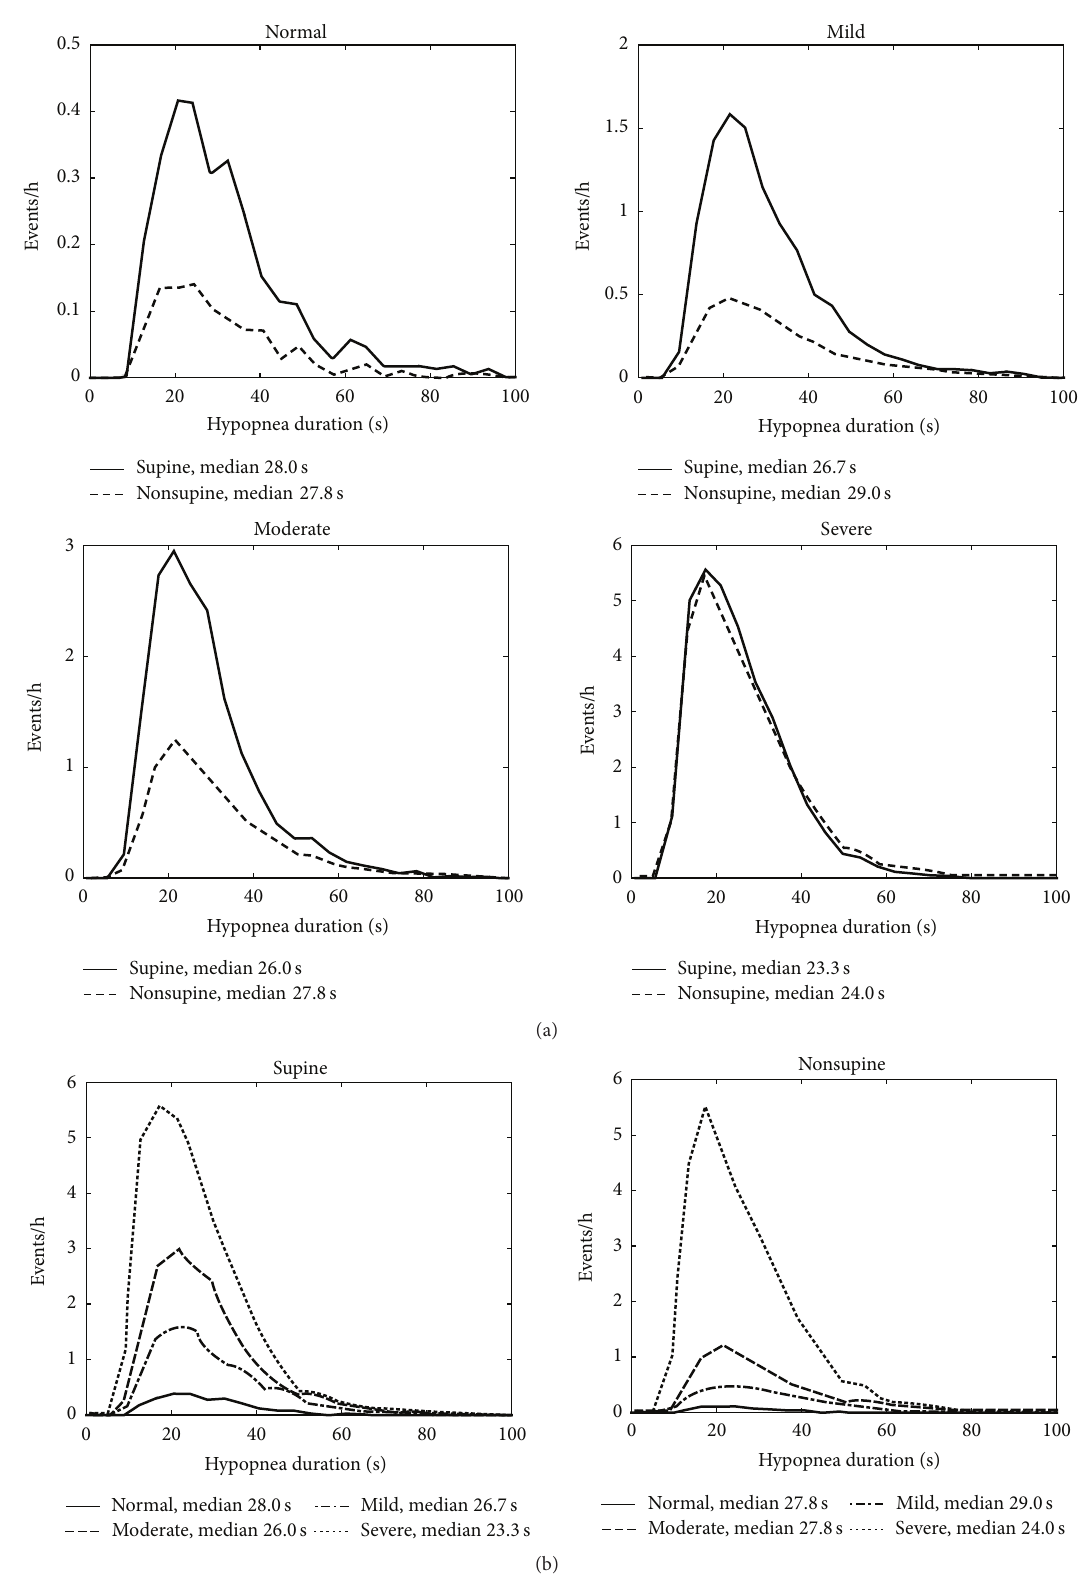
Figure 4: (a) Positional sleeping time adjusted distributions of the durations of individual hypopnea events in supine and nonsupine positions in different OSA severity categories and (b) distributions in nonsupine and supine positions as a function of OSA severity. In every OSA severity category, excluding normal category, the hypopnea events were slightly longer in nonsupine position than in supine position. Based on the mixed model analysis, the differences are statistically significant in all OSA severity categories excluding the normal